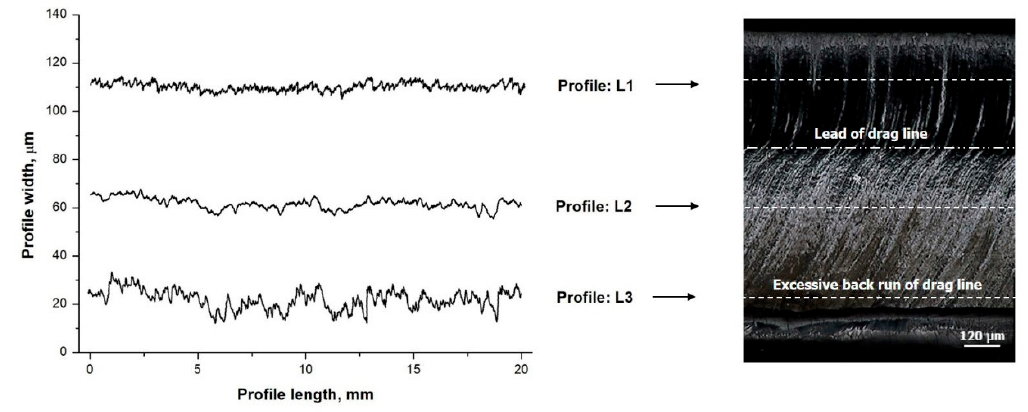
Figure 23. Deviation of drag lines (in accordance with ISO 17658:2015) in 2.5 mm thick St37-2 cut with Cs = 100% and P = 50%.